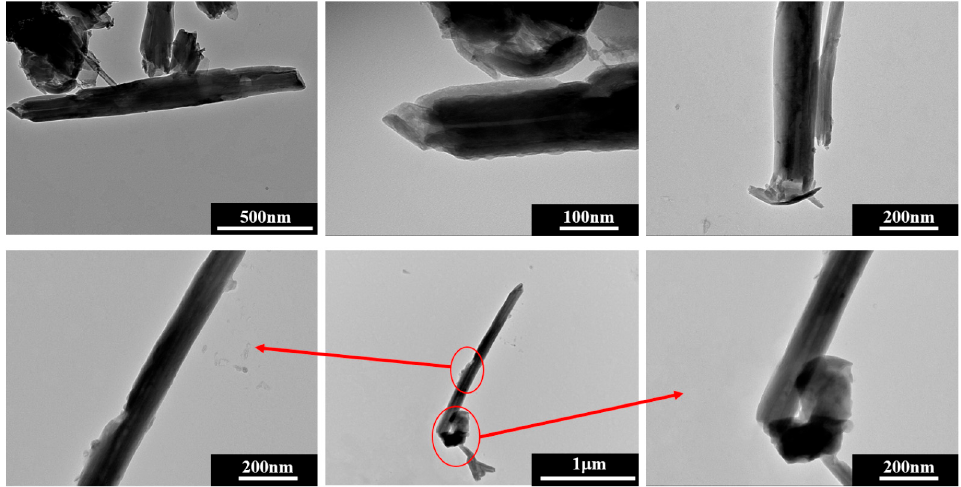
Figure 2. TEM images of HNTs/Ca(OH) 2 with calcium phosphate end-stoppers.